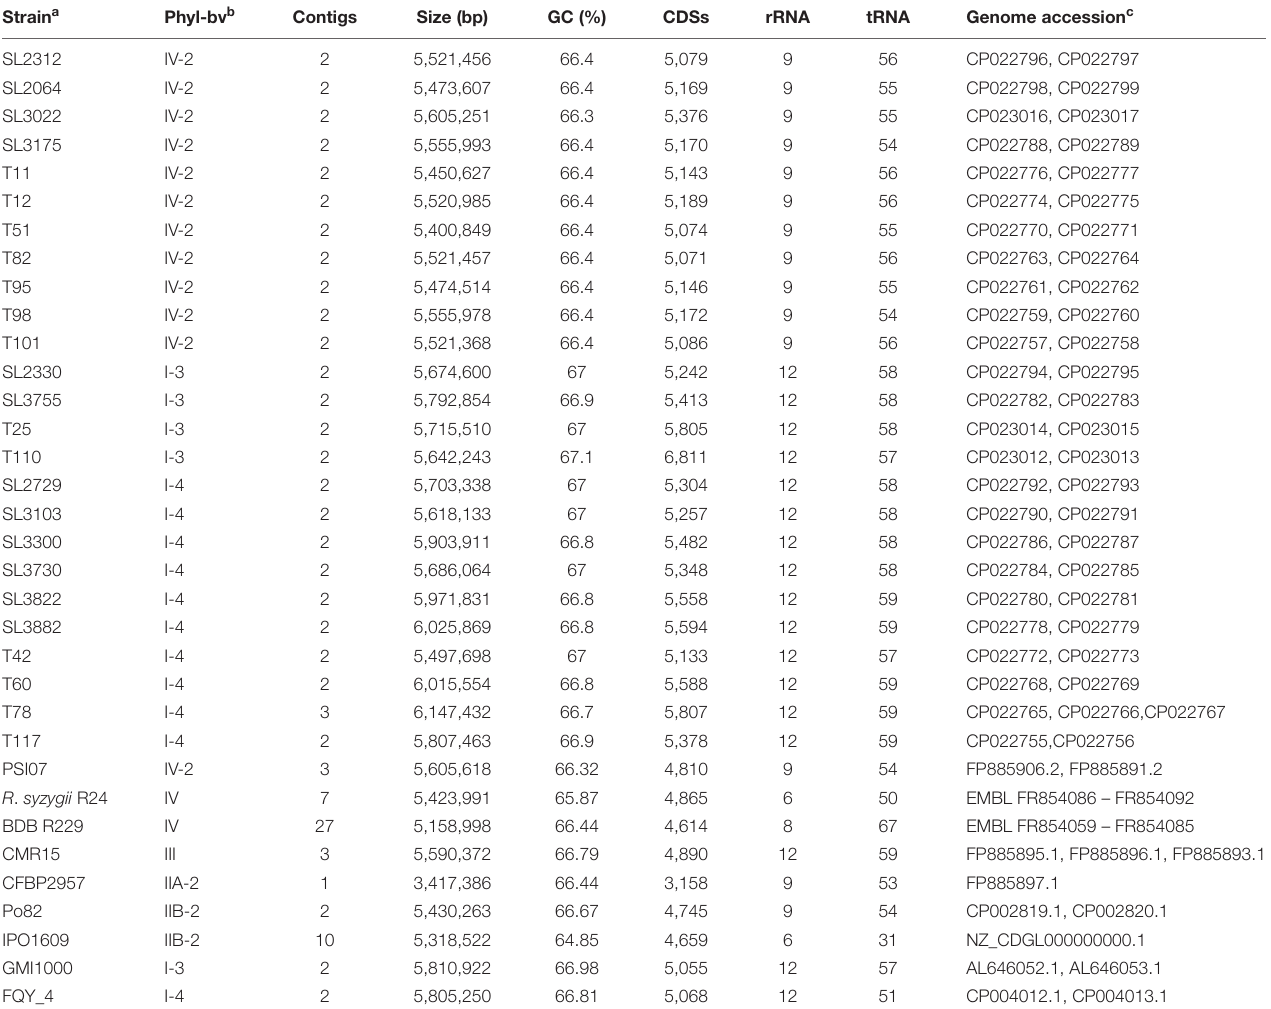
TABLE 1 | General genome features of the RSSC strains used in this